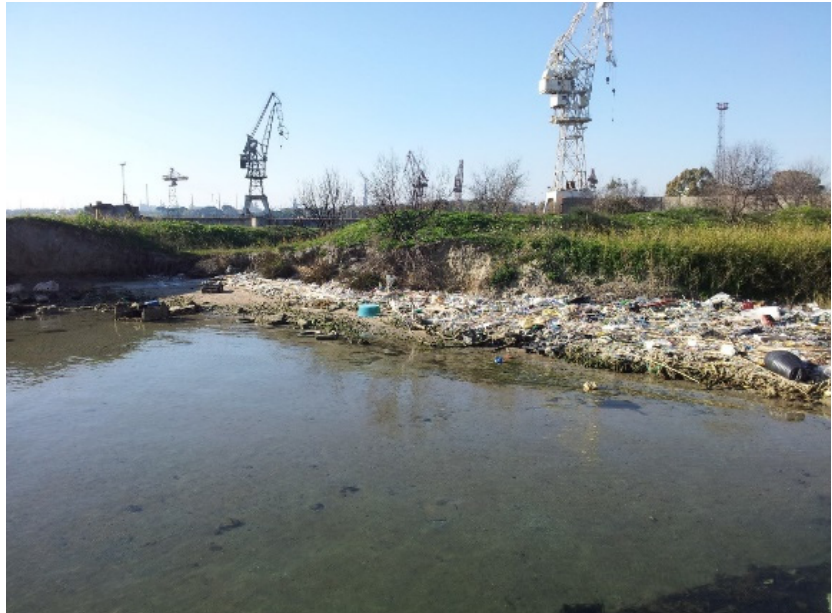
Figure 17. Inspection in which we verified the presence of waste on the banks. First inlet of the Mar Piccolo (Puglia Region). September